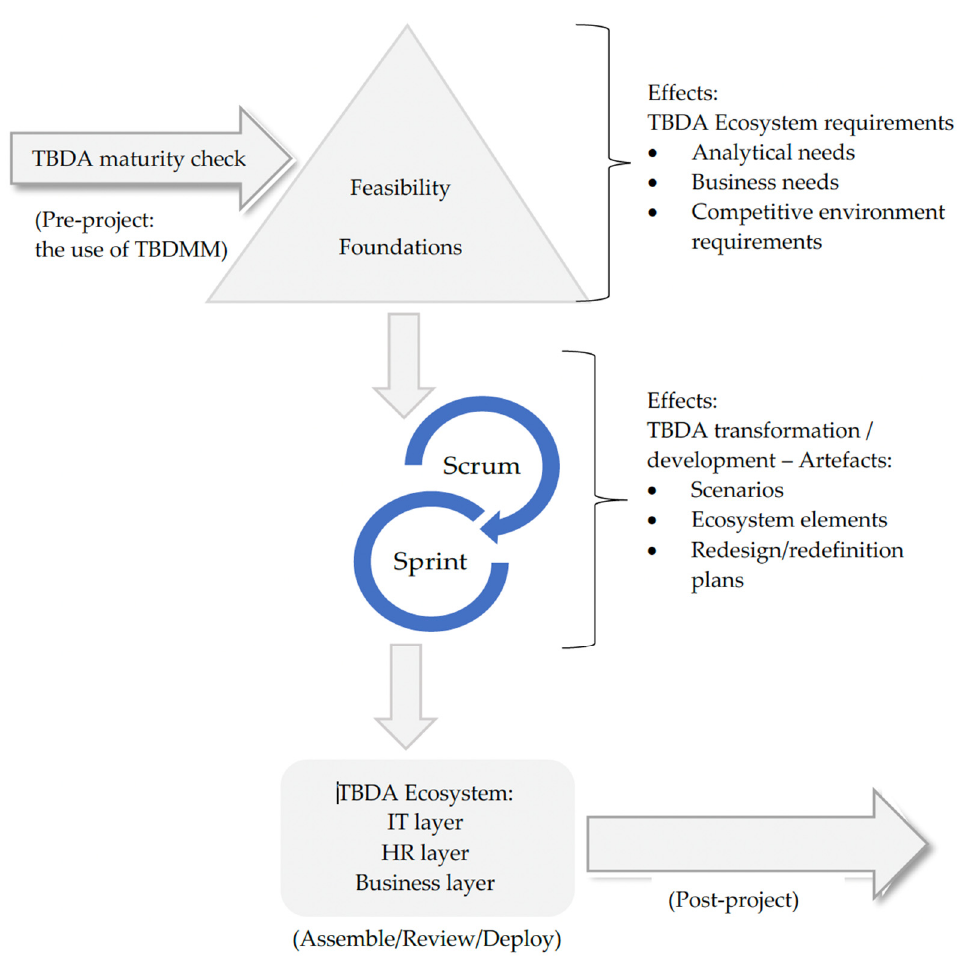
Figure 4. DSDM Agile Project Framework translated into the TBDA implementation framework.